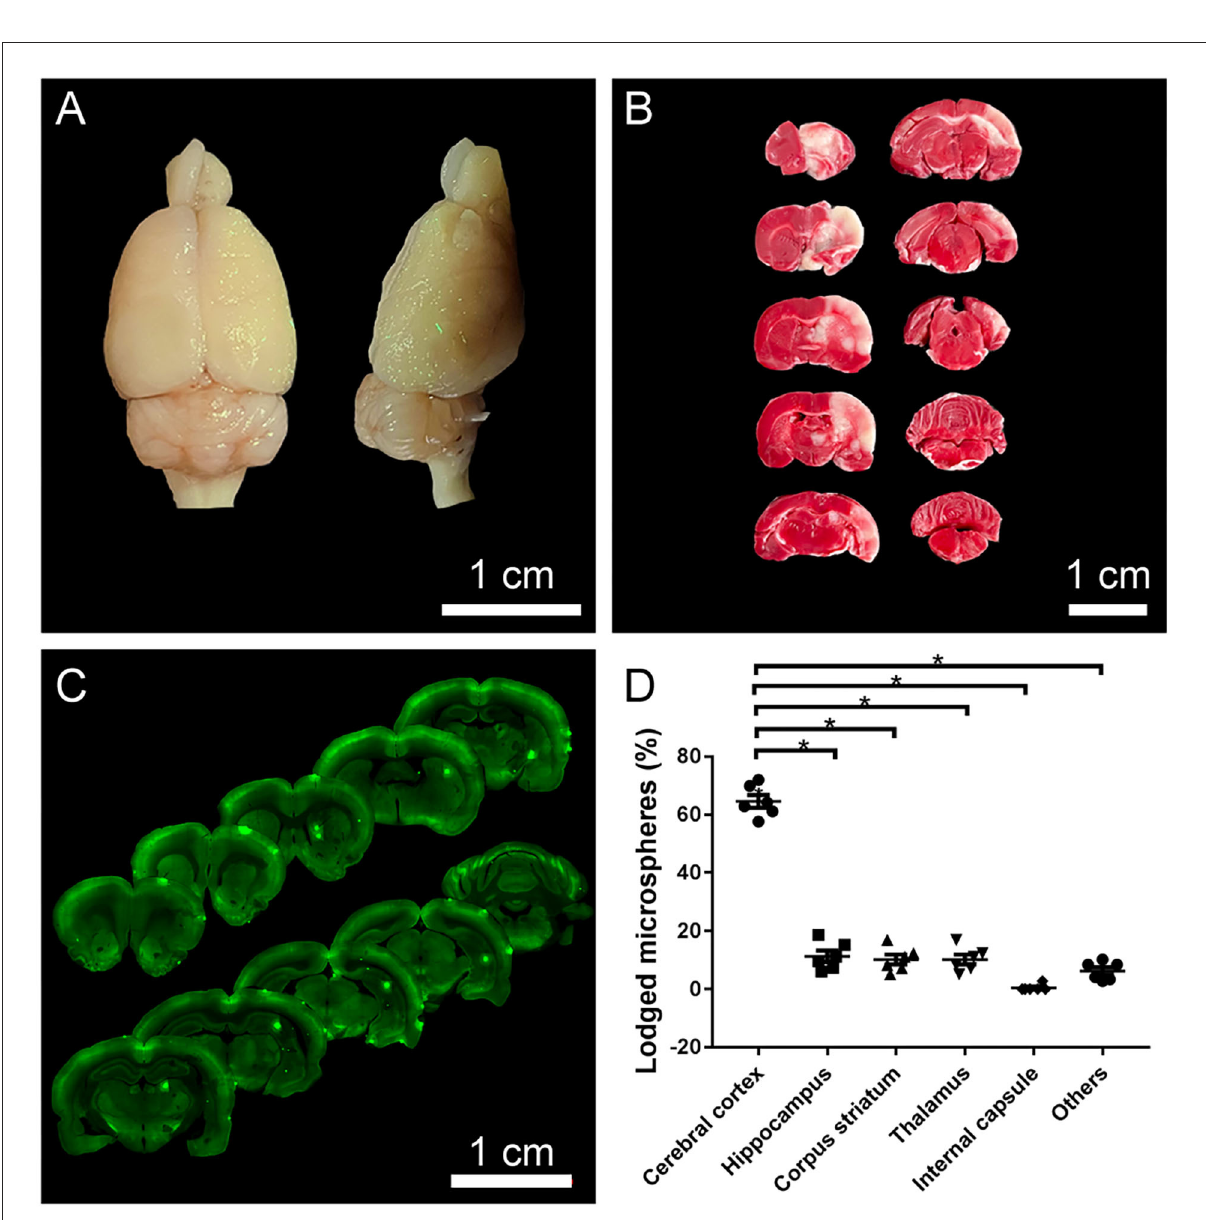
FIGURE2 The distribution of fluorescent microspheres and infarcts. (A) A representative photograph from the brain surface of a rat 1 day after operation under UV illumination showing typical distribution of fluorescent microspheres (green dots) lodged in the cerebral cortex. (B) A representative photograph of TTC staining. The red area indicated normal areas, and the white areas indicated the infarctions, detecting that the ipsilateral cerebral cortex, hippocampus, and striatum were affected. (C) A representative photograph from the coronal sections of the brain with VS120 Virtual Slide System showing the lodged microspheres (green dots) in the ipsilateral cerebral cortex, hippocampus, striatum. (D) The distributional percentage of microspheres in the different regions and the cerebral cortex were more susceptible to damage. * p < 0.05 vs. other regions (cerebral cortex vs. hippocampus, striatum, thalamus, internal capsule, and